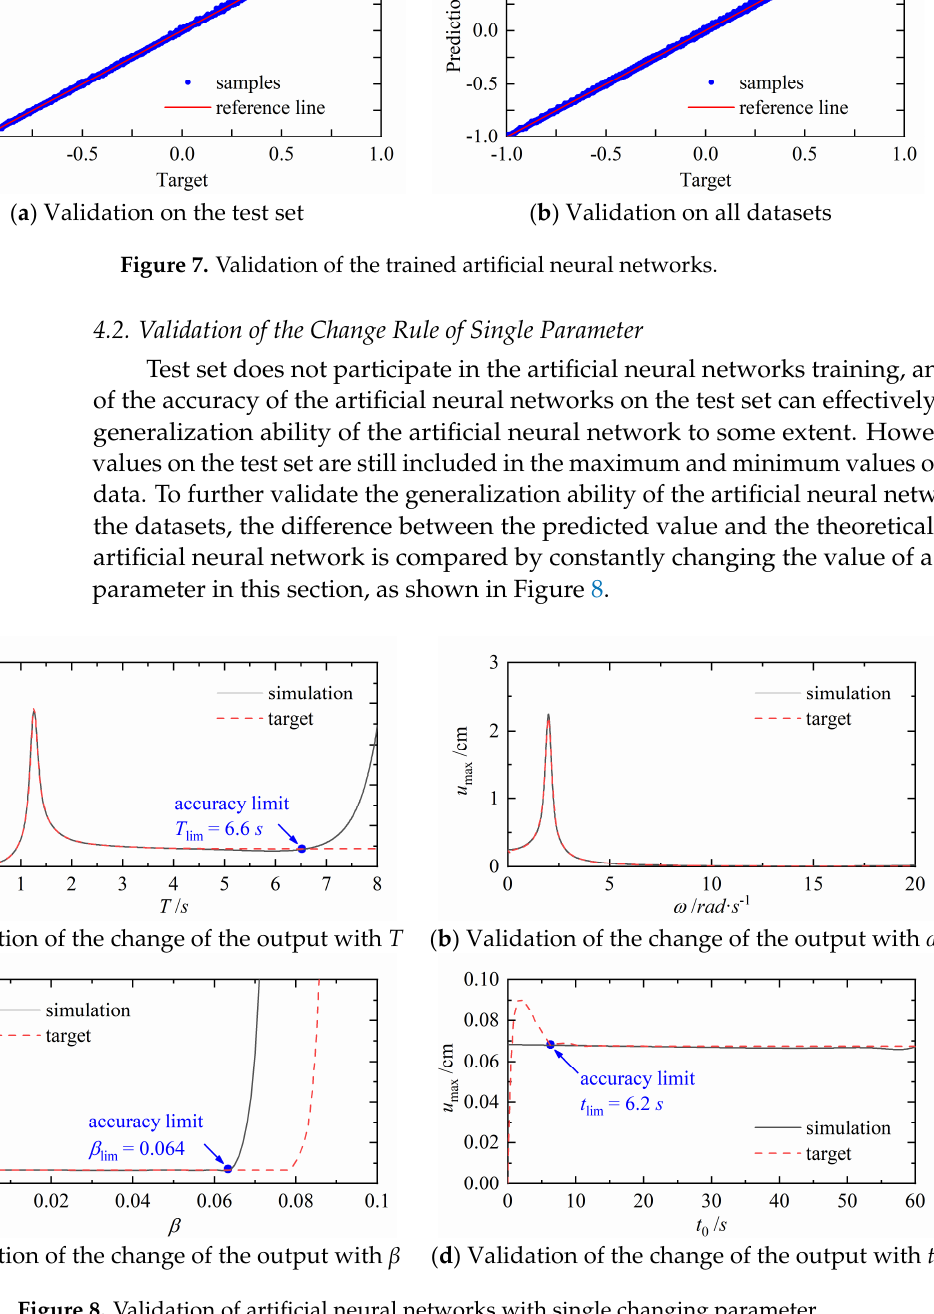
Figure 6. The evolution of fitness function.